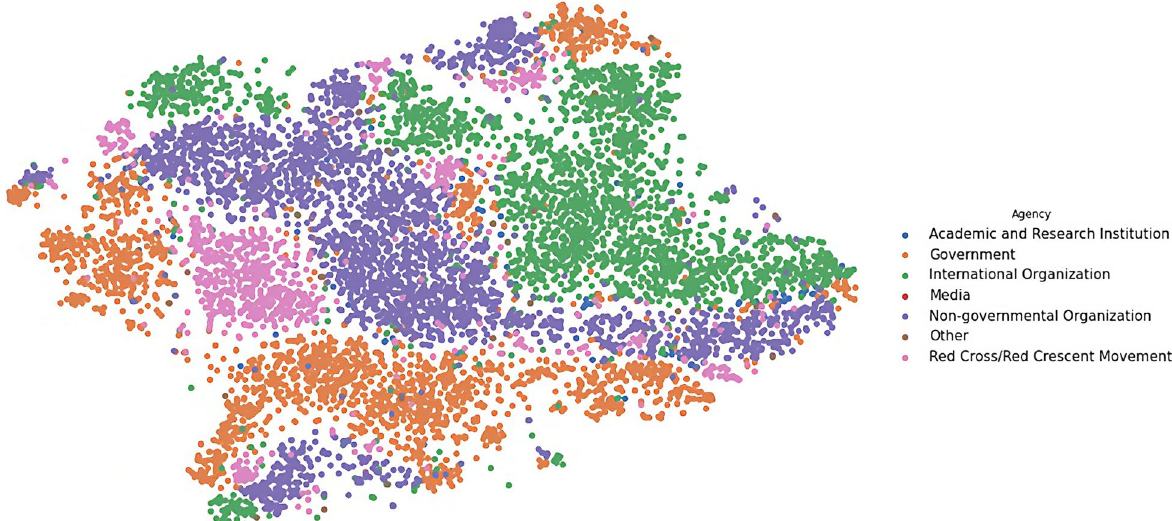
Fig. 8 Visualisation of actors’ affiliation